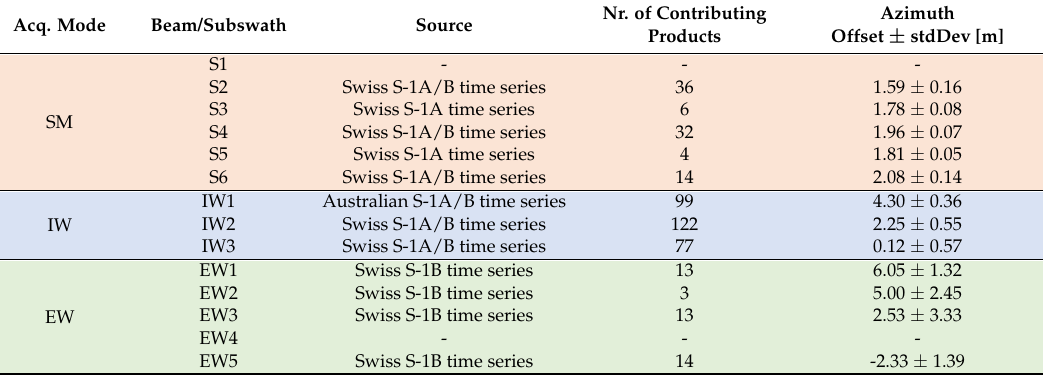
Table 3. Azimuth offsets (and associated precision) measured for individual beams or